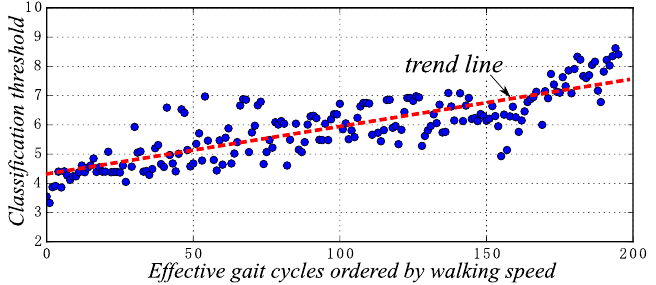
Figure 12. The classification threshold distributions during the EGC. The walking speeds of the EGC increase gradually along the horizontal